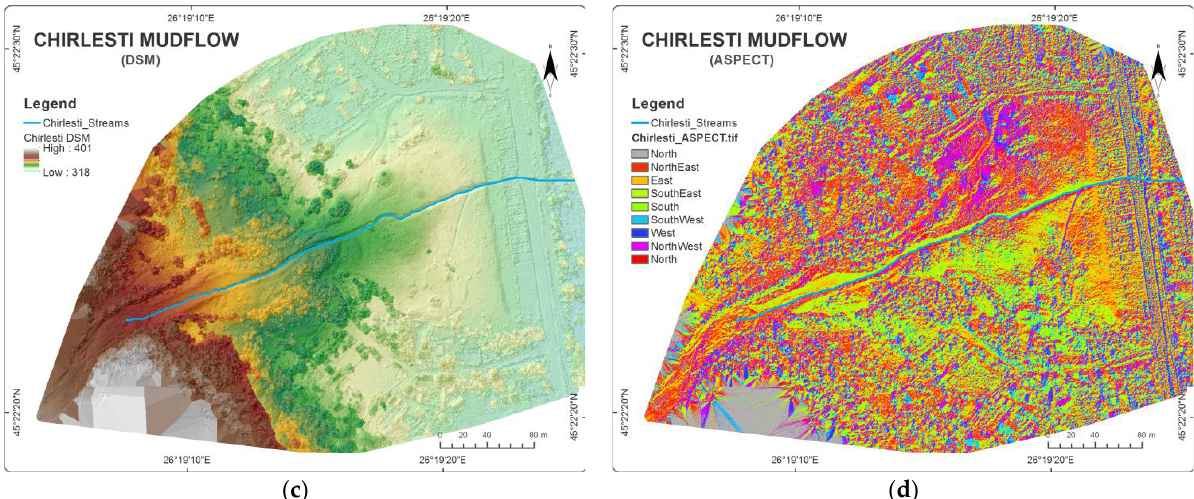
Figure 6. The case study of Chirlesti Mudflow in Romania captured by the drone flight January 2021: